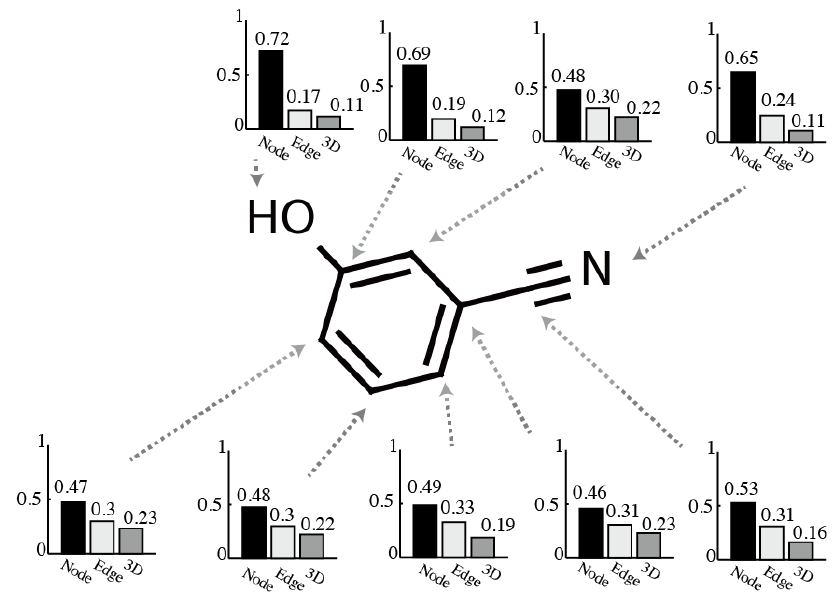
Figure 7. Visualization results of attention